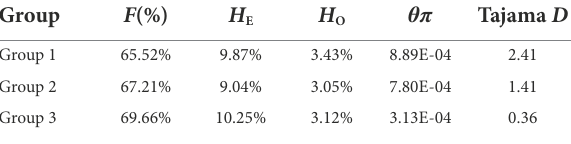
genetic differentiation between regional populations